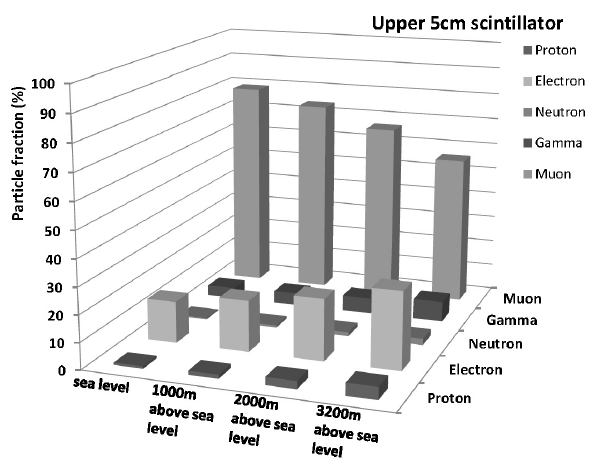
Fig. 4. Fractions of elementary particles detected by the upper layer of the SEVAN detector.